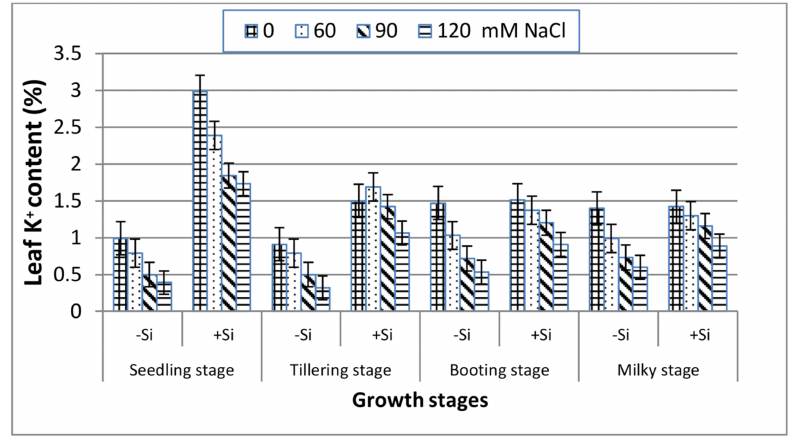
Figure 4. Effect of NaCl on the leaf K + content of wheat at different growth stages in the presence and absence of silicon.